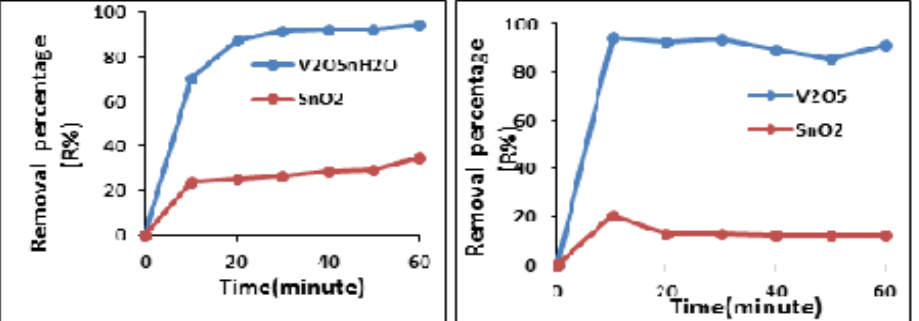
Figure (6): The removal percentage (R%) of MB onto V 2 O 5 .nH 2 O and SnO 2 nanoparticles heating at 90 ◦ C and 500 ◦ C for 60 min)